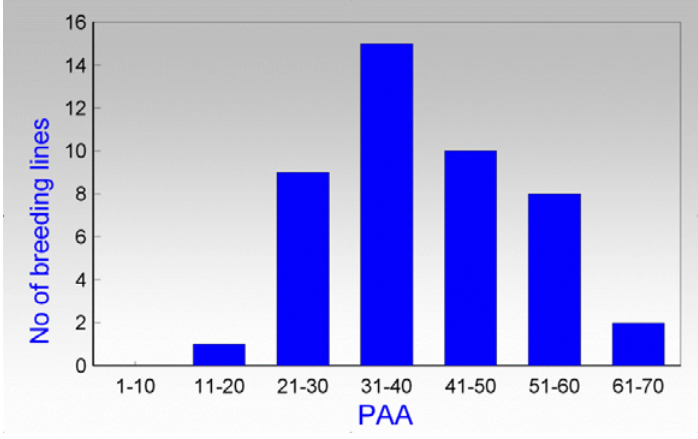
Figure 3. Frequency distribution of potential allelopathic activity (PAA) of winter wheat-rye translocation lines including five wheat and three triticale cultivars (pooled standard error of PAA =